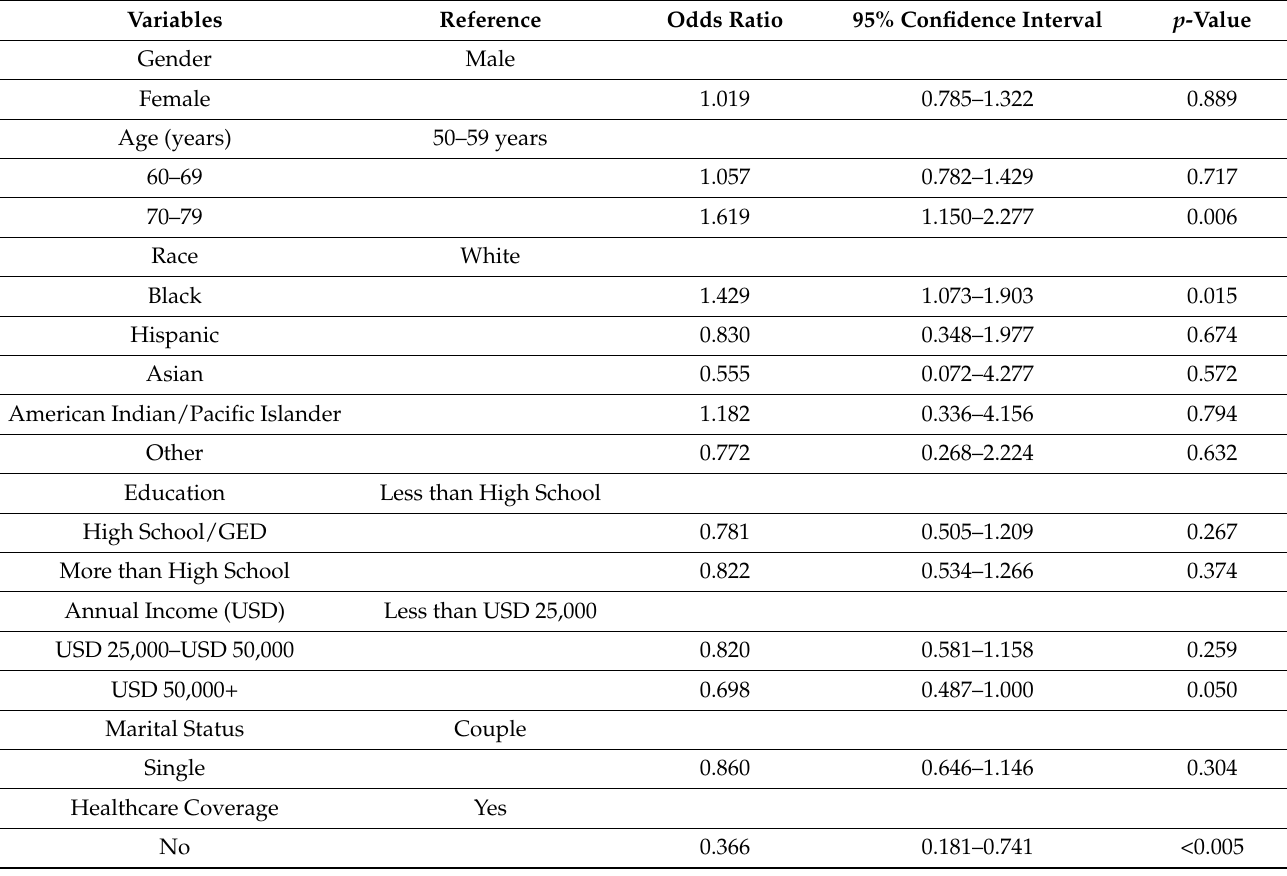
Table 3. Odds of blood stool test utilization among study respondents in Georgia: BRFSS